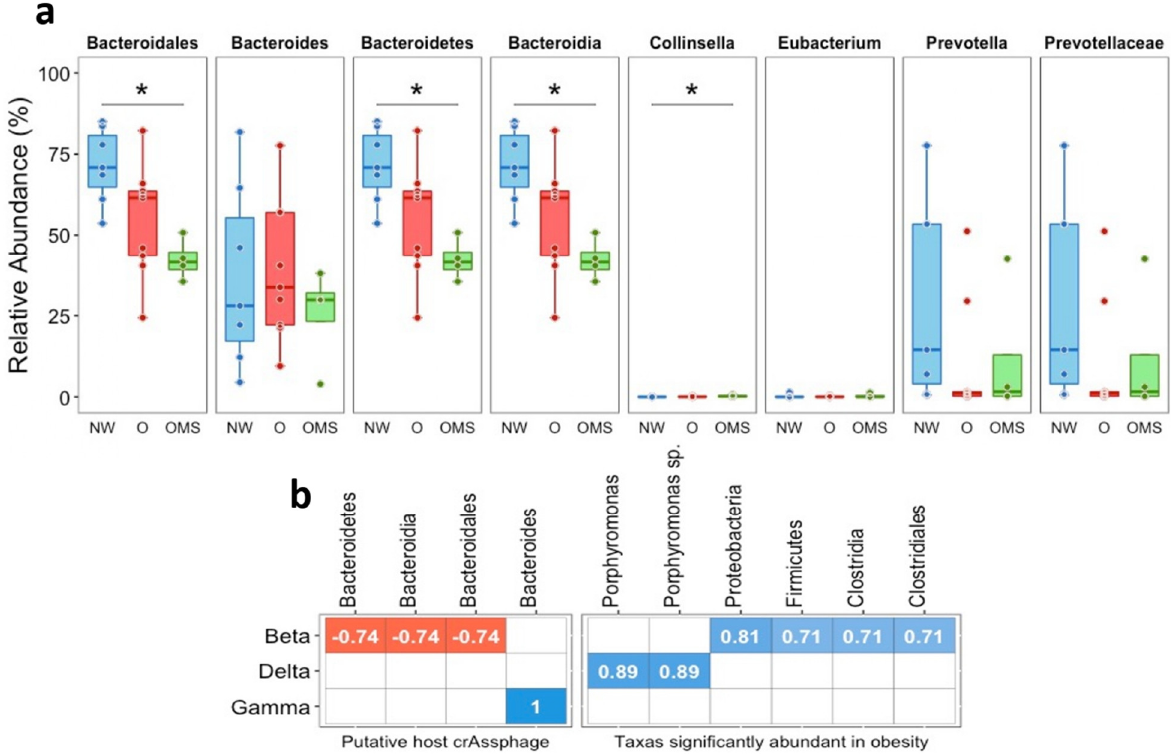
Figure 5. ( a ) Relative abundance of putative bacterial crAssphage hosts. Each point shows the abundance for each sample, with the boxes showing the group’s distribution. Error bars represent the median ± SD. The p-value resulting from comparisons among groups is shown above the box plots, *: p < 0.05. ( b ) Spearman correlation plot between the abundances of bacteria and crAssphage subfamilies.